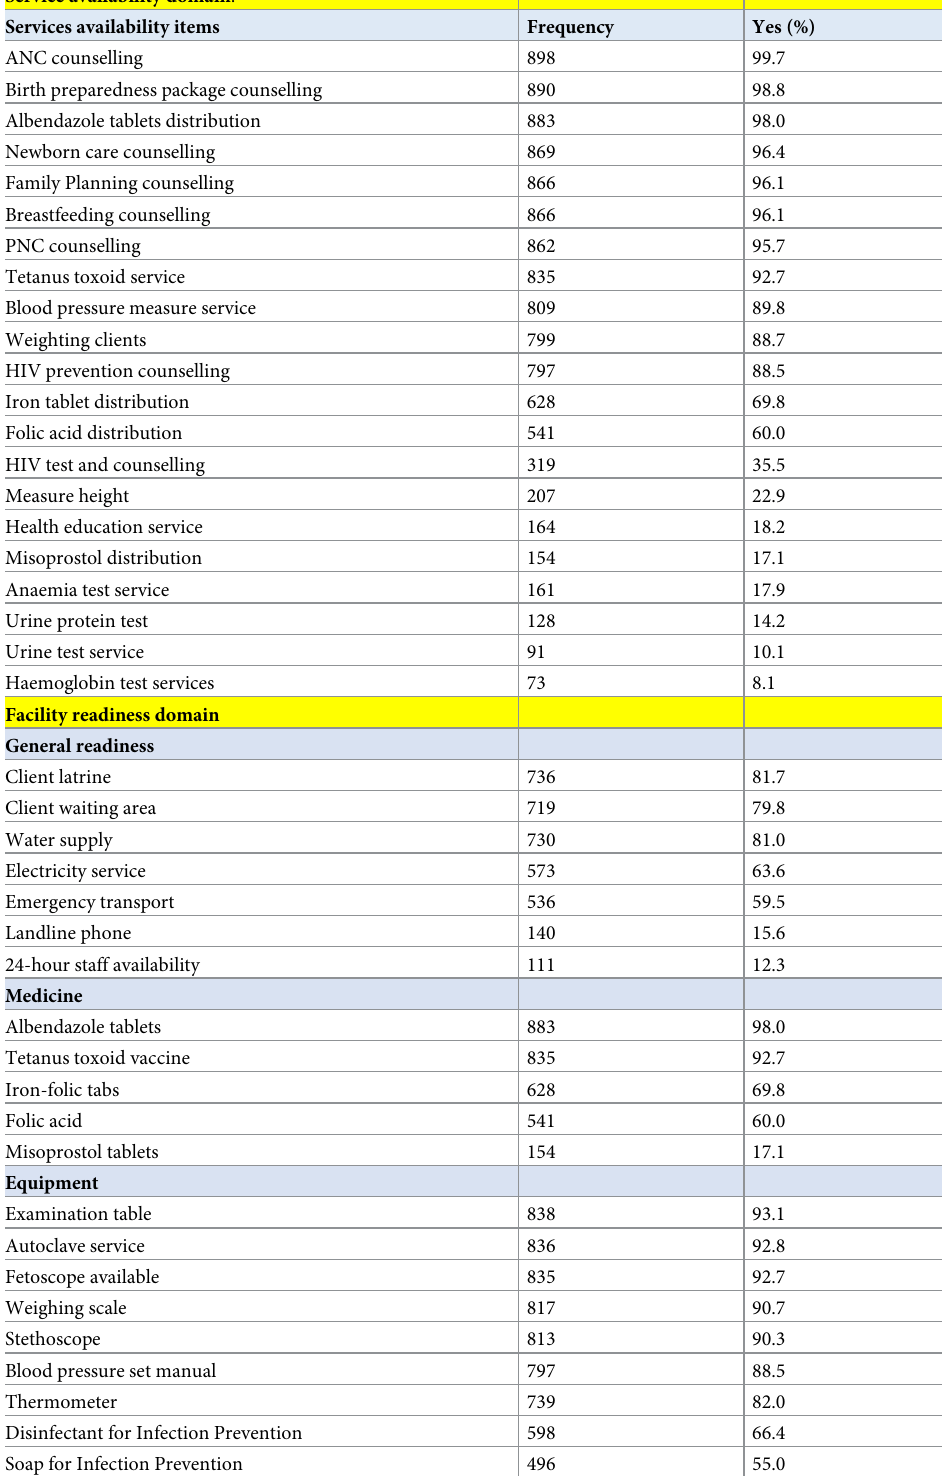
Table 2. Service availability and facility readiness assessment items in health facilities for ANC services (N =